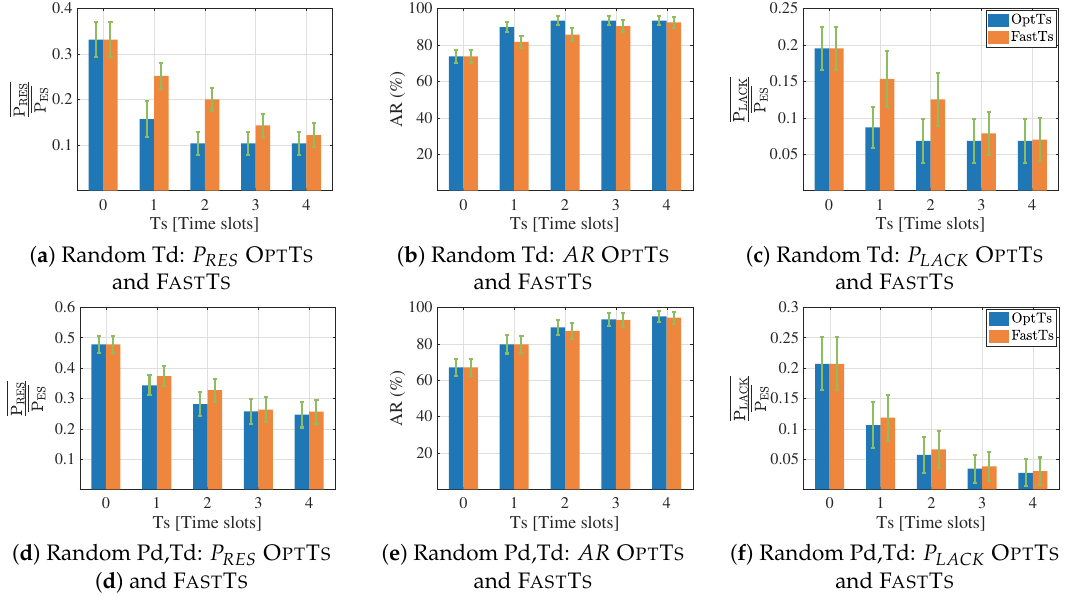
Figure 15. Performance evaluation of O PT T S and F AST T S for Random Cases in small-scale scenarios. Parameters: N = 6 and numPart = 2 for all cases, the rest of parameters according to Case C and Case D of Table